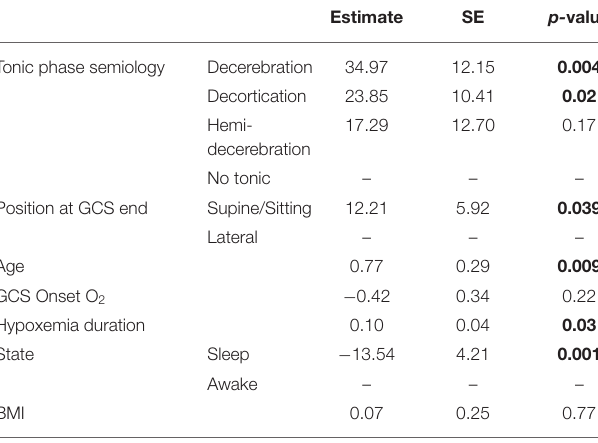
TABLE 4 | Multivariate analysis of electroclinical seizure features and cardiorespiratory data with PGES duration.